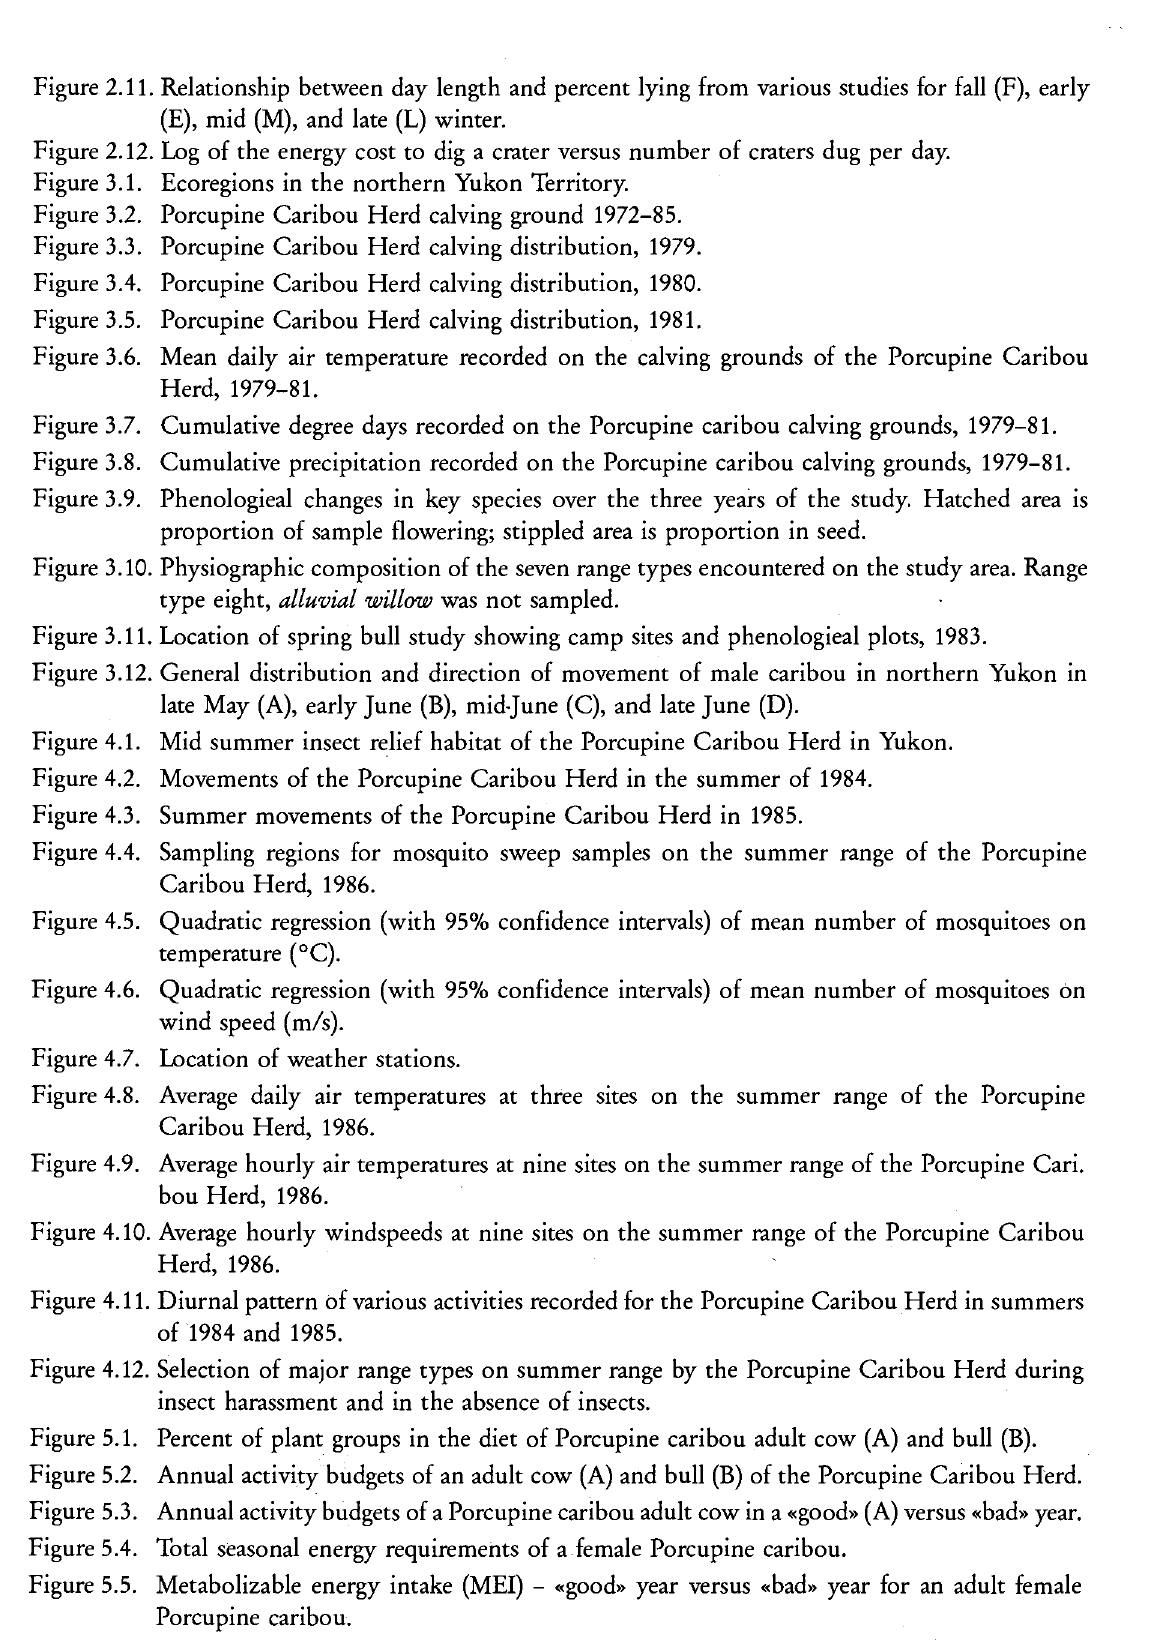
Figure 2.12. Log of the energy cost to dig a crater versus number of craters dug per day. Figure 3.1. Ecoregions in the northern Yukon Territory. Figure 3.2. Porcupine Caribou Herd calving ground 1972-85. Figure 3.3. Porcupine Caribou Herd calving distribution, 1979. Figure 3.4. Porcupine Caribou Herd calving distribution, 1980. Figure 3.5. Porcupine Caribou Herd calving distribution, 1981. Figure 3.6. Mean daily air temperature recorded on the calving grounds of the Porcupine Caribou Herd, 1979-81.